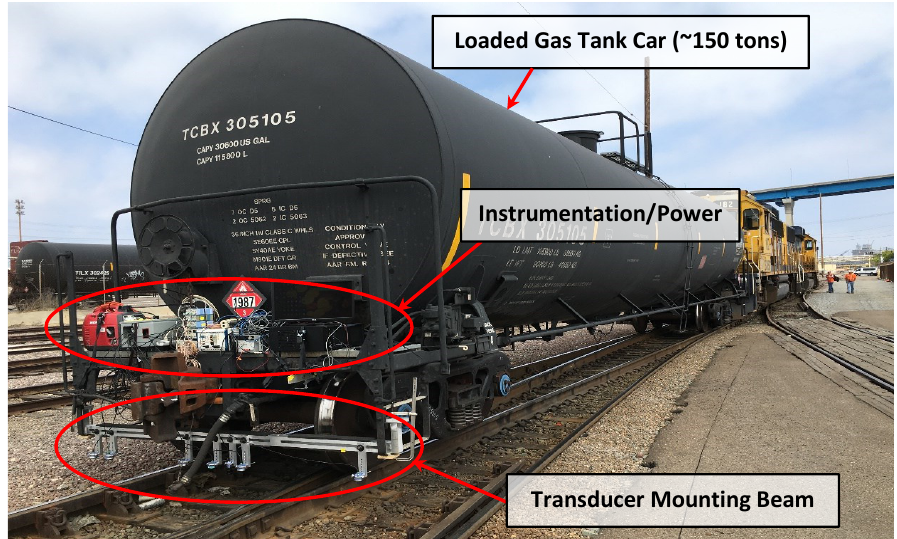
Figure 9. Test setup for in-motion tie deflection measurements at the BNSF rail yard in San Diego, CA,